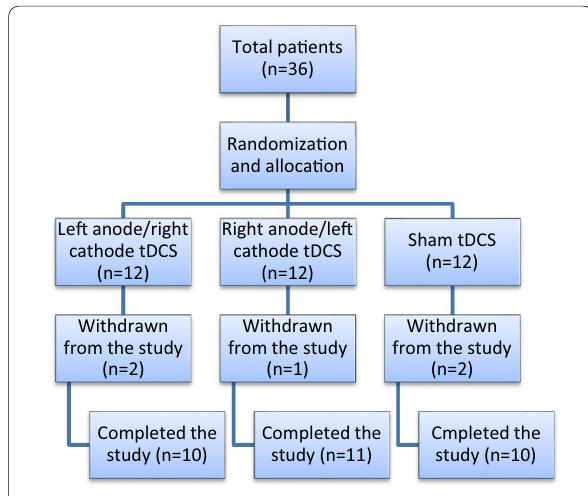
Fig. 1 Flowchart of the study